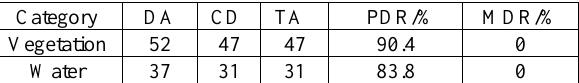
Tab 2. Accuracy of crowdsourced vector data anomaly